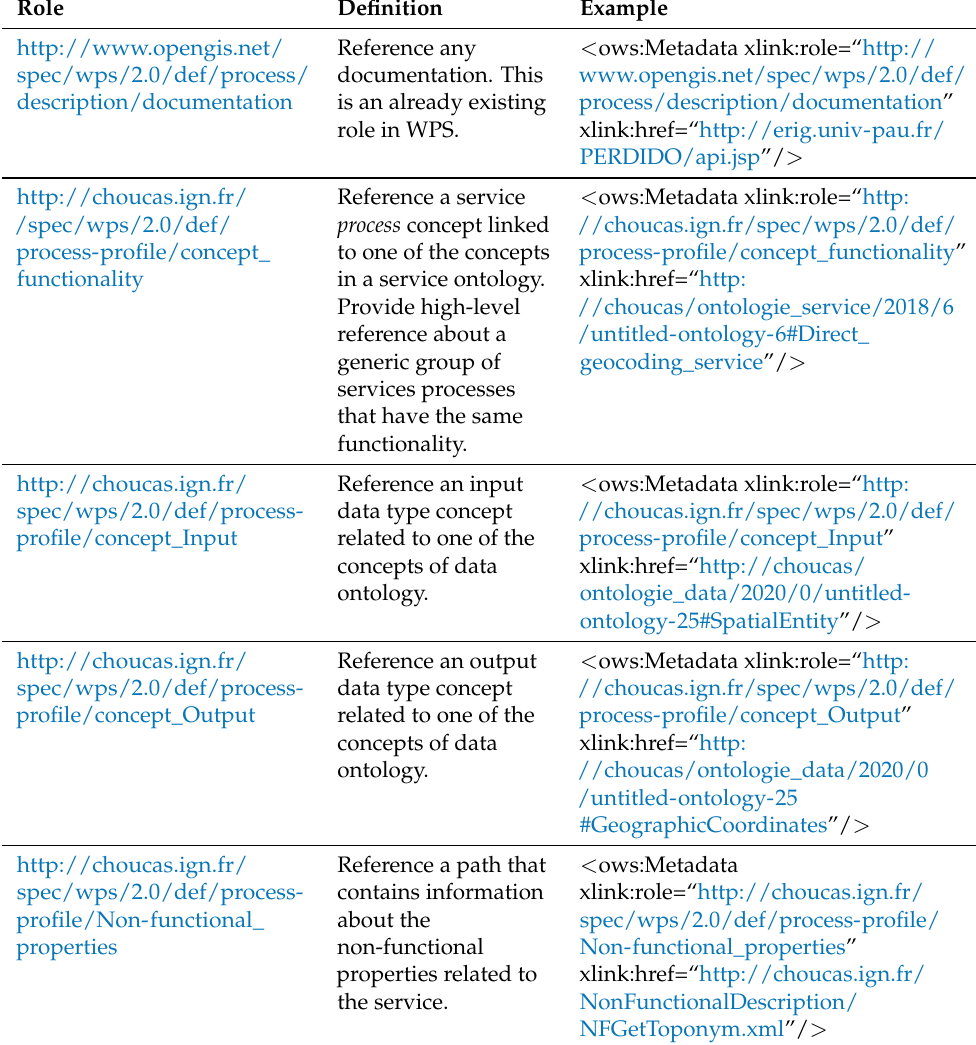
Table 2. Extended roles for metadata tag for SAWPS (Semantic Annotation for